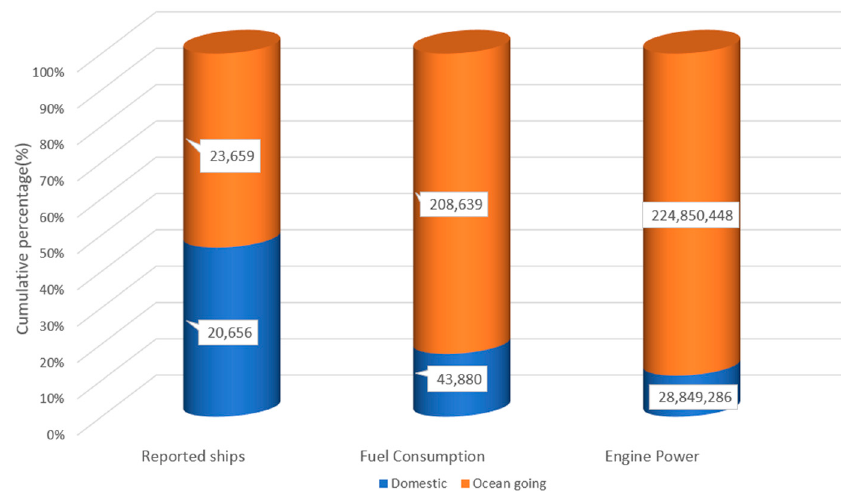
Figure 7. Proportion of fuel oil consumption and number of reported cases.